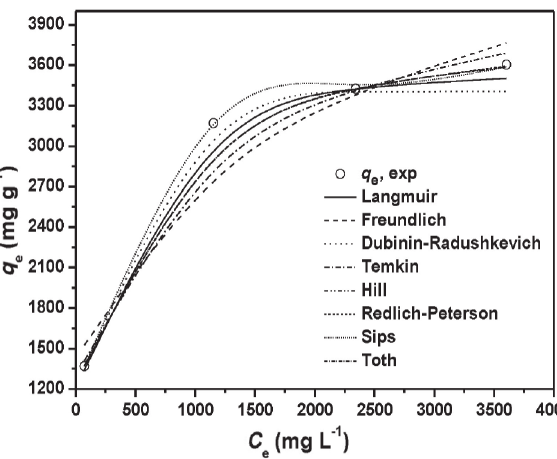
Fig. 8 – Comparisons of various non-linear two- and three-parameter adsorption isotherm models used in the study (initial acrylic acid concentration = 4323 mg L –1 , adsorbent dosage = 1 g L –1 , time = 125 min, and temperature = 300.15